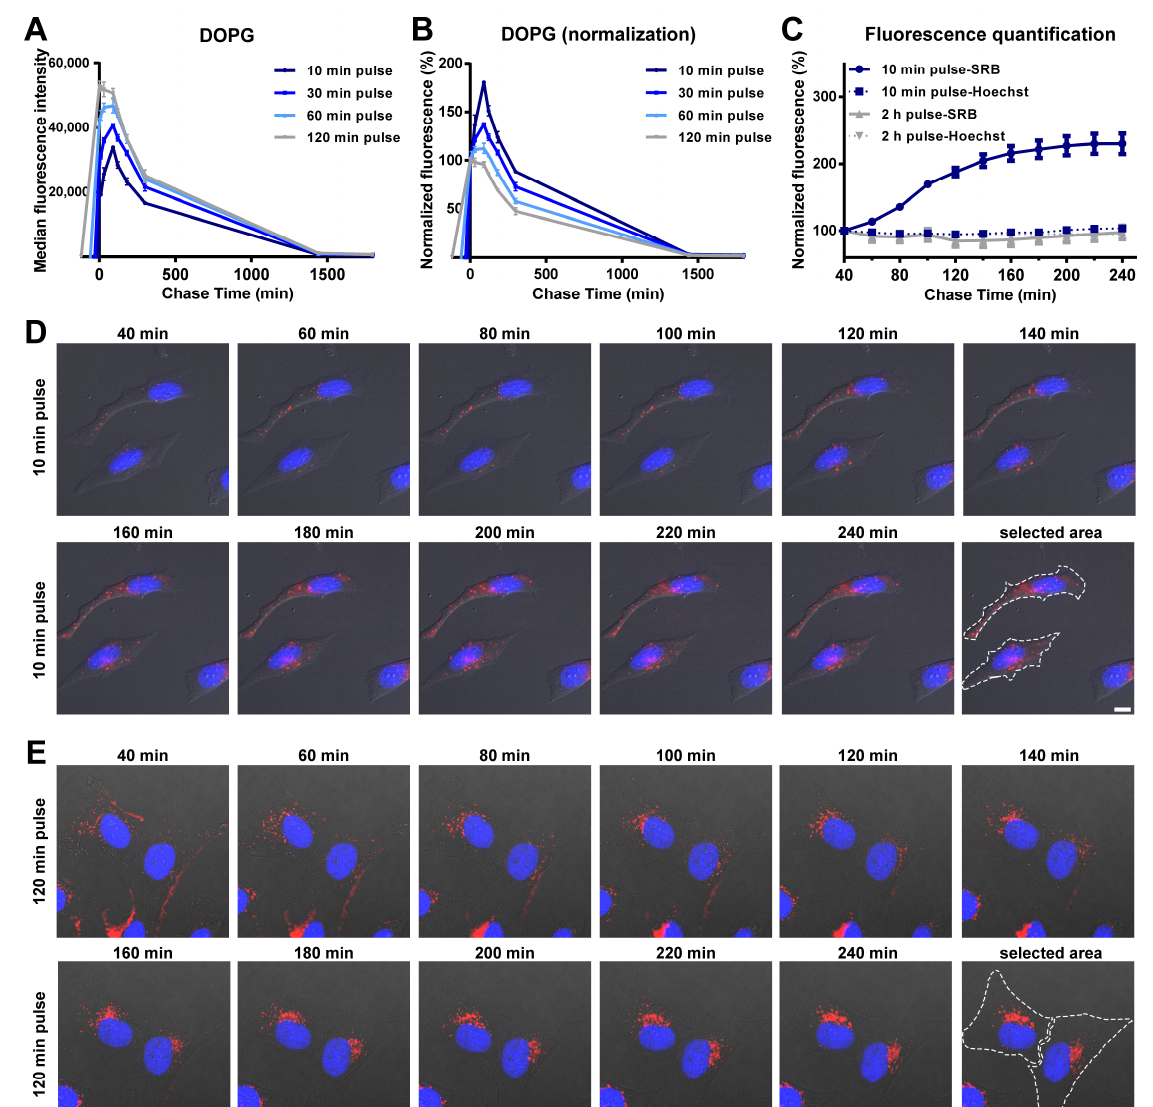
Figure 2. Intracellular release behavior of SRB from DOPG liposomes. ( A , B ) Release kinetics in HeLa cells after exposure to DOPG liposome for different times. Briefly, HeLa cells were exposed to 62 µ g/mL DOPG liposomes in cMEM for 10, 30, 60 and 120 min (pulse), prior to 3 washes with cMEM to remove the excess liposomes and further incubation in fresh cMEM without liposomes (chase). Cells were then collected at different chase times for flow cytometry analysis as described in Methods. The results are the average and standard deviation over 2 replicates of the median cell fluorescence intensity obtained by flow cytometry. In ( B ), the same data are shown after normalization for the fluorescence at 0 h chase. ( C ) SRB and Hoechst fluorescence quantification from fluorescence imaging of live HeLa cells after 10 min or 120 min exposure to 62 µ g/mL DOPG liposomes (pulse) and chase in fresh cMEM without liposomes. The mean fluorescence intensity of two separate cells in the imaging field (see Figure 2D–E for area selection) was calculated and normalized for the starting fluorescence at the beginning of the imaging. The results are the average and standard deviation of the results obtained over 2 cells. The solid lines show the results for SRB and the dash lines for the Hoechst to stain the nuclei. ( D , E ) Fluorescence images of HeLa cells after exposure to 62 µ g/mL DOPG liposomes (pulse) for 10 min ( D ) and 120 min ( E ) and chase in fresh cMEM without liposomes for up to 240 min. Fluorescence images were taken every 20 min, starting 40 min after liposomes were removed (40 min chase). Blue: Hoechst stained nuclei. Red: SRB encapsulated in liposomes or free SRB. Scale bar: 10 µ